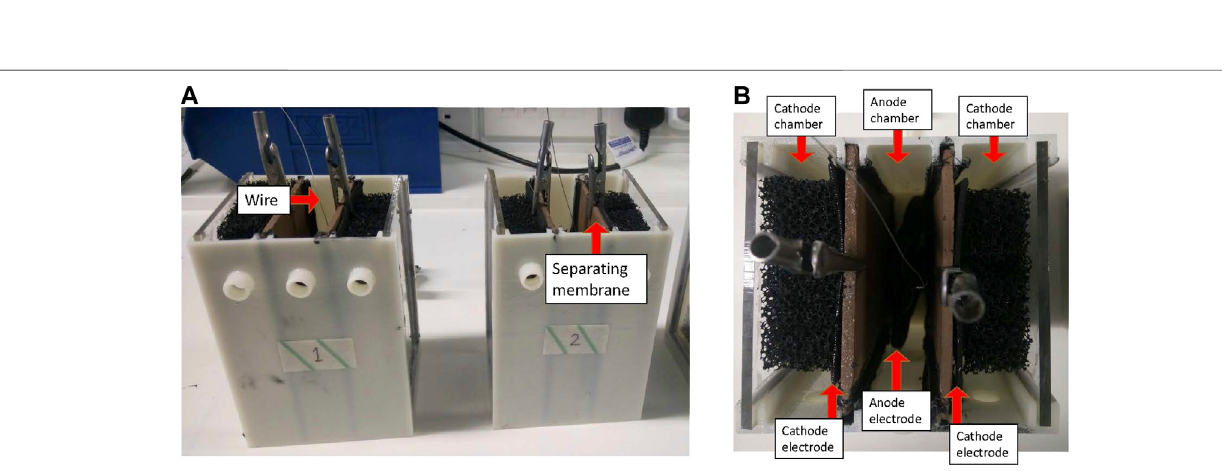
Frontiers in Robotics and AI |